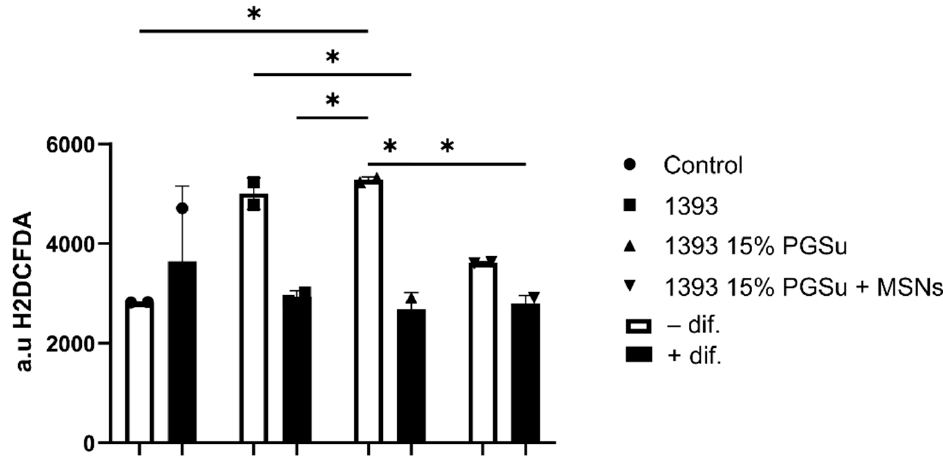
Figure 16. ROS levels as measured from hAMSCs lysates after 21 days of incubation with the scaffolds (70 μ g/mL). *=p<0.001.